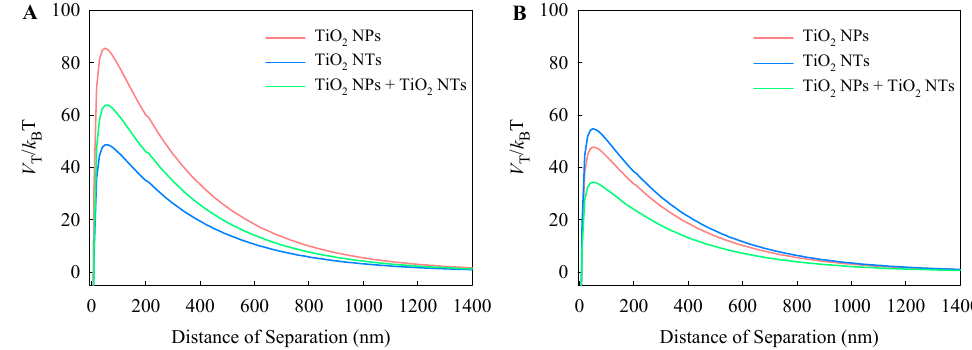
Figure 2. Total potential energy (V T ) curves for the TiO 2 particles in the single and binary systems at 0 h ( A ) and 96 h ( B ).